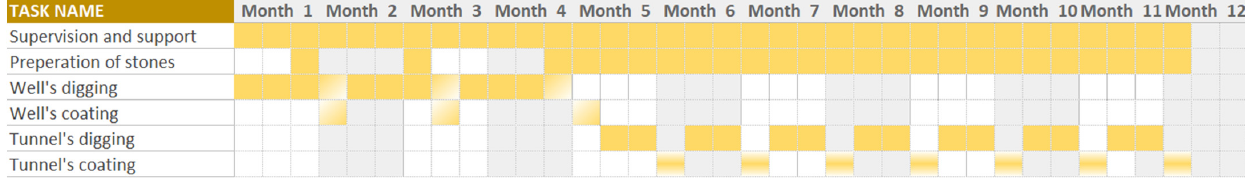
Figure 26. Indicative Gant chart of the duration of a module.